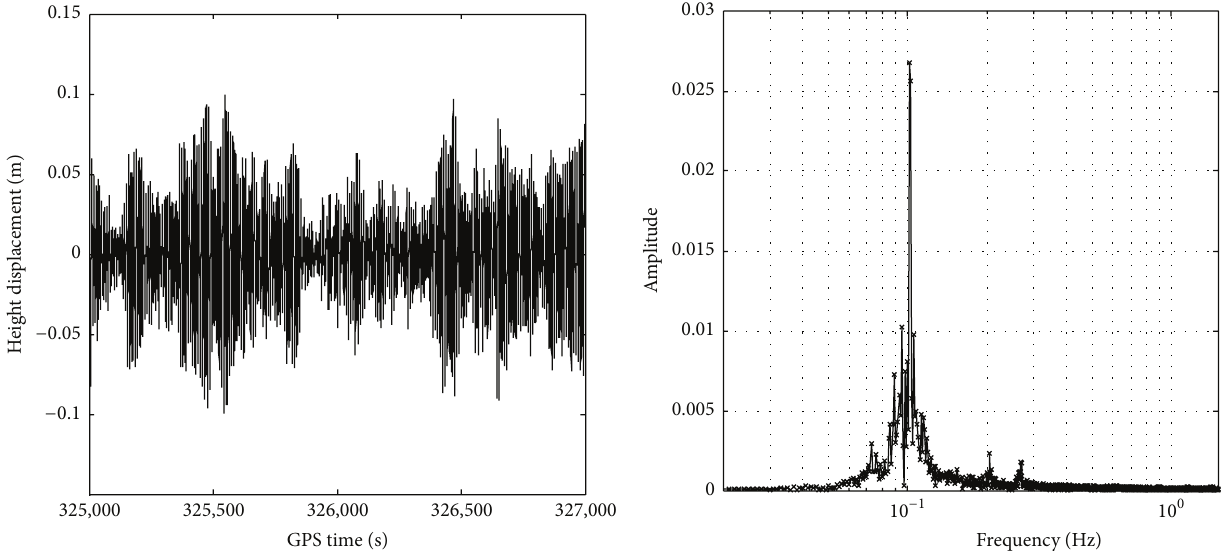
Figure 20: The filtered height displacements and corresponding frequencies during the wind speed decreasing